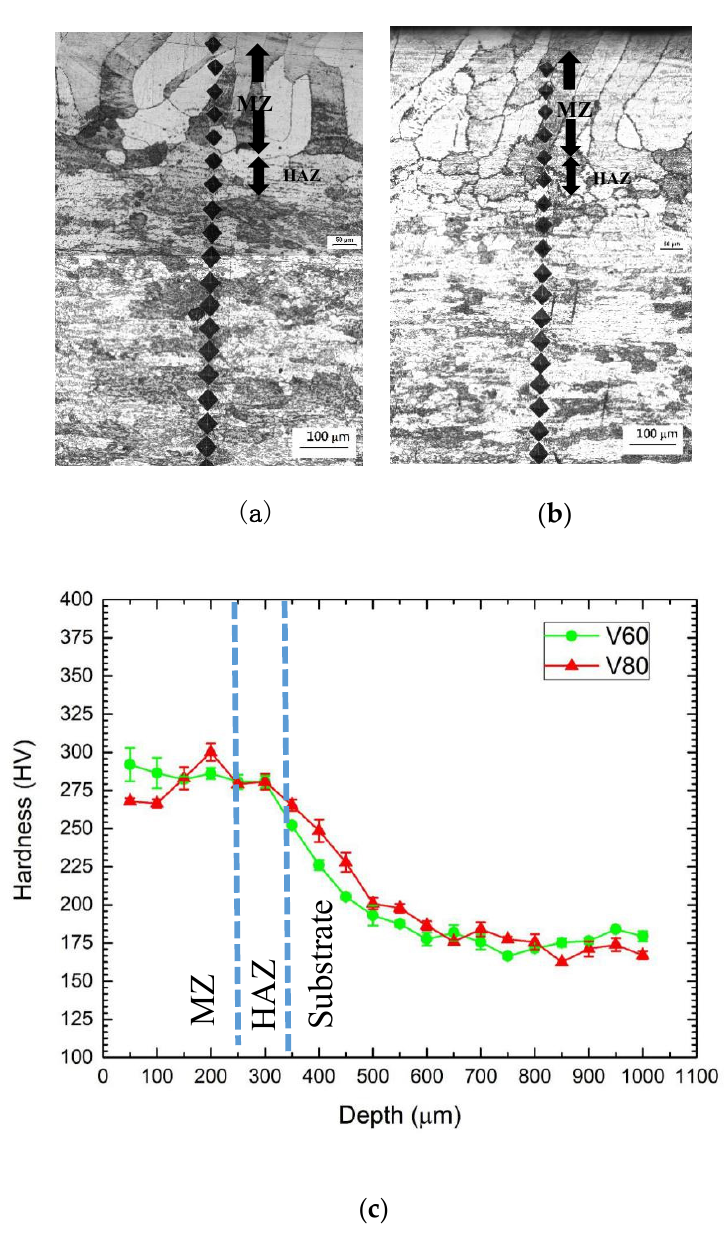
Figure 4. Microhardness measurement along the cross-sections of the laser-melted specimens ( a ) V60, ( b ) V80, and ( c ) their microhardness profiles.